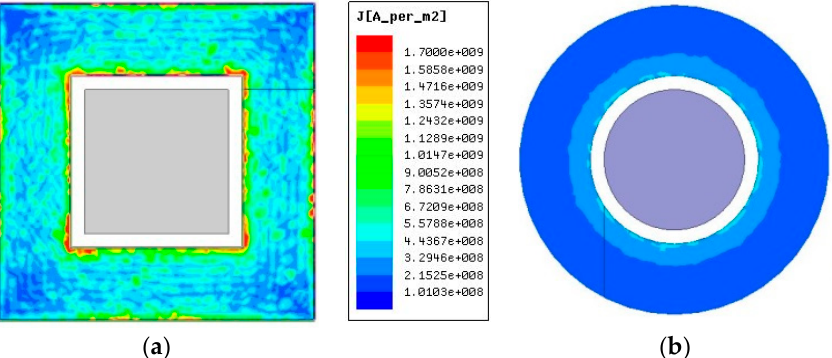
Figure 8. Relationship between the winding shapes of effective core cross sections and current distribution: ( a ) square-shaped cross section; ( b ) round cross section.